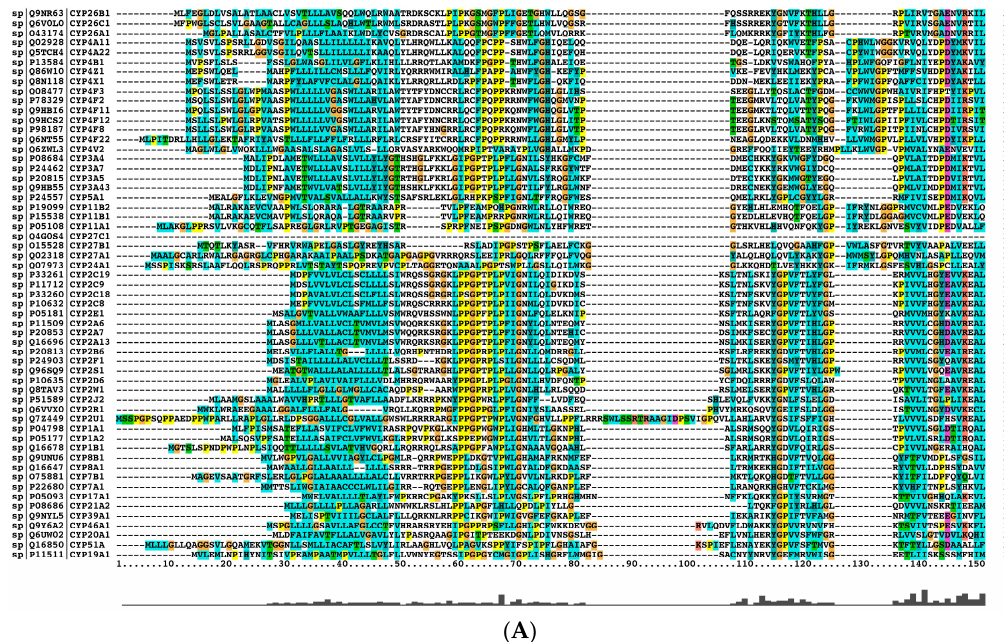
Figure 1. Cont. Figure 1.